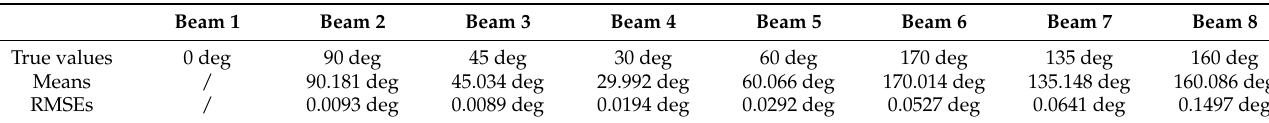
Table 3. Relative phase statistical